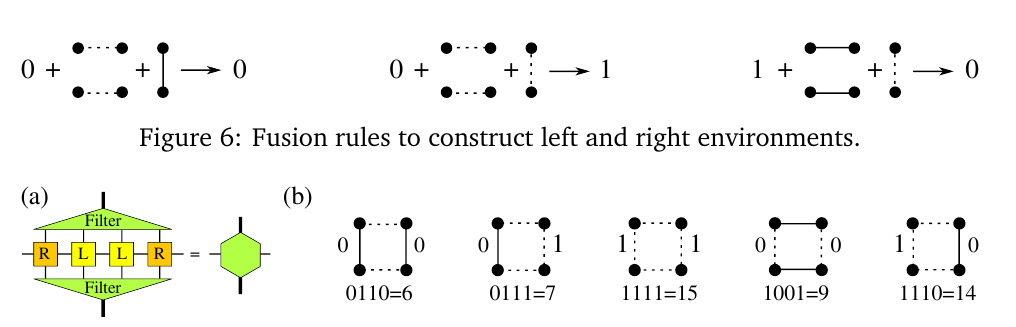
Figure 7: (a) Graphical representation of four-site MPO. The filter tensor allows to pass through only those states that are not forbidden by quantum dimer model listed in (b). The index of each configuration of (b) in the full basis of four-site Hamiltonian can be obtained using, for example, binary representation with "0" corresponds to a dimer and "1" to an empty bond as shown below each sketch Importantly, the size of each sector ’0’ and ’1’ of the environments grows with the number ( n ) = F ( n ) and Ω ( n ) = F ( n − 1 ) , with F ( 0 ) = F ( 1 ) = 1. of rungs n as the Fibonacci series: Ω 0 1 The total size of the Hilbert space for the left and right environments also grows as a Fibonacci series and is given by F ( n ) + F ( n − 1 ) = F ( n + 1 ) . It is easy to check that in the system with n rungs in the left and n rungs in the right environments and with two-rung MPO shown in l r Fig.7(b) the total Hilbert space is given